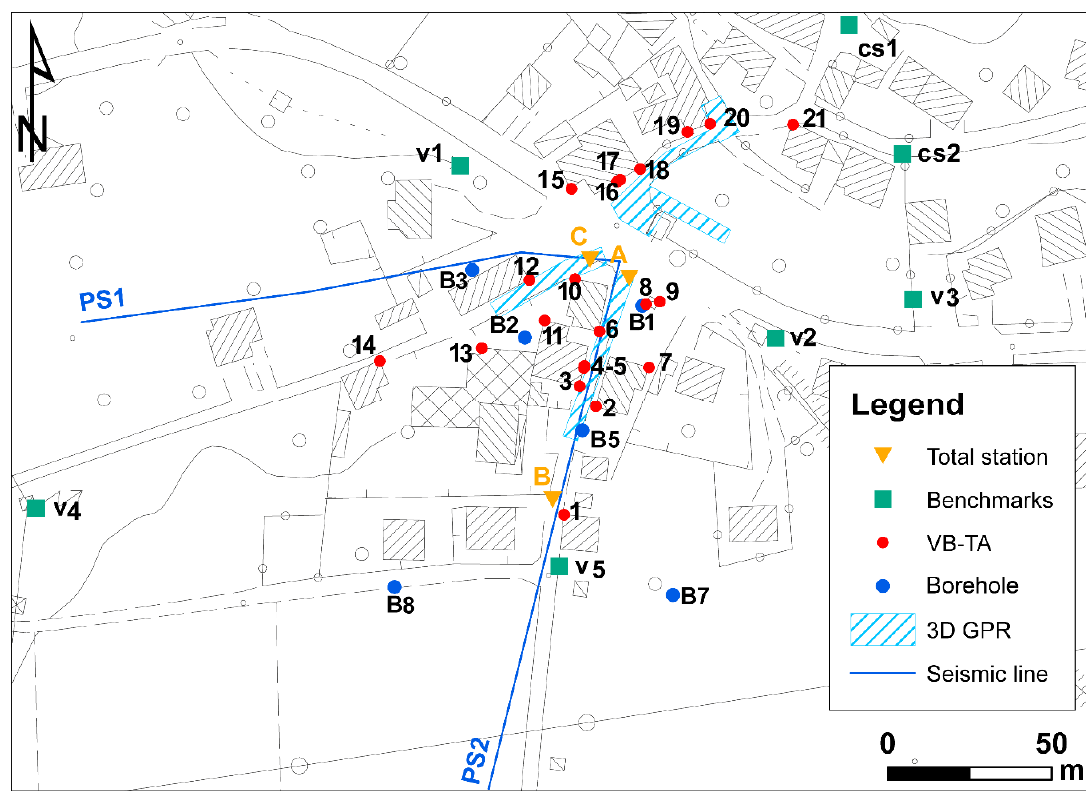
Figure 6. Location of direct and indirect measurements map: seismic lines (PS1 and PS2); benchmarks v1–v5 and cs1–cs2; B1–B8 boreholes; 1–21 leveling monitoring points; A, B, C total station monitored points; in pale blue—the area covered by the full 3D GPR survey.